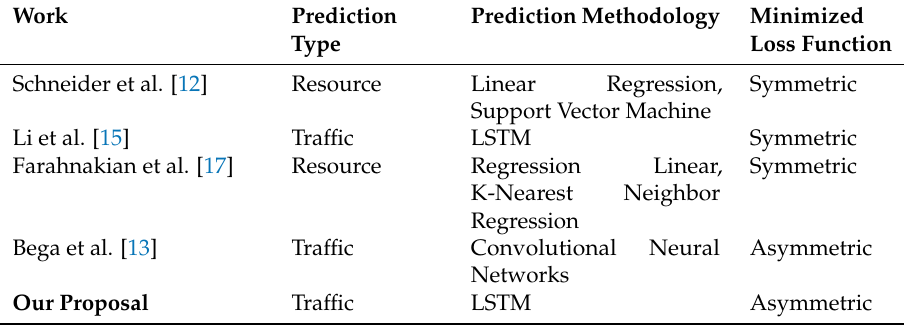
Table 1. Comparison between our proposal and the main related